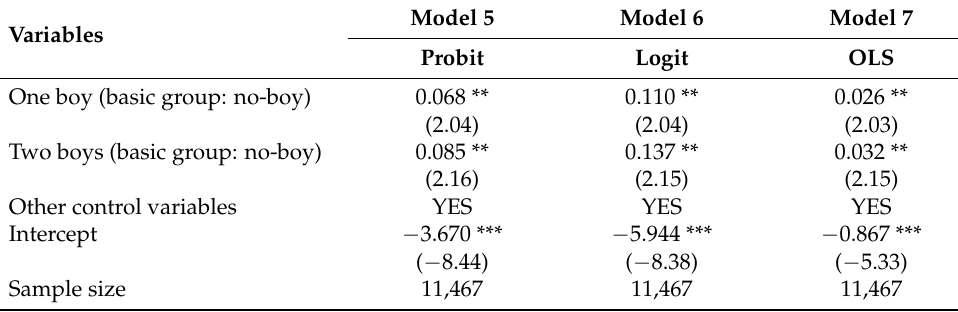
Table 3. Empirical analysis of the number of boys and migrant women’s